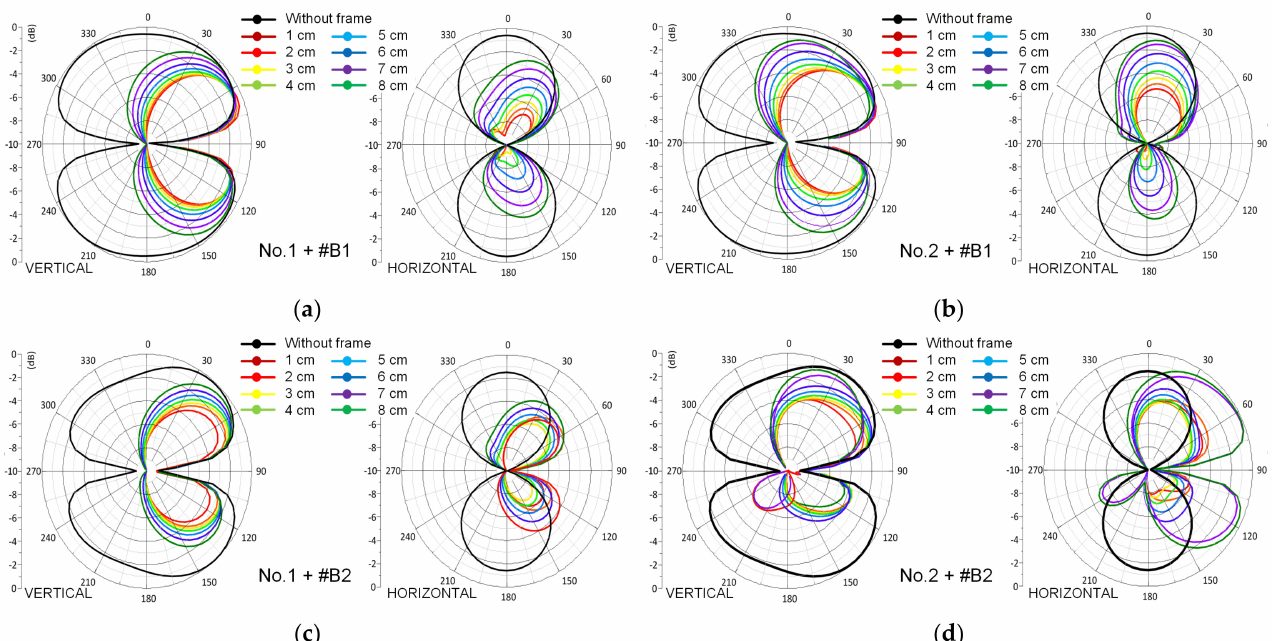
Figure 20. Directional diagrams of radiation pattern vs. separation distance between unit frame and antenna radiator in arrangements ( f 0 = 866 MHz): ( a ) No.1+#B1; ( b ) No.2+#B1; ( c ) No.1+#B2; ( d )